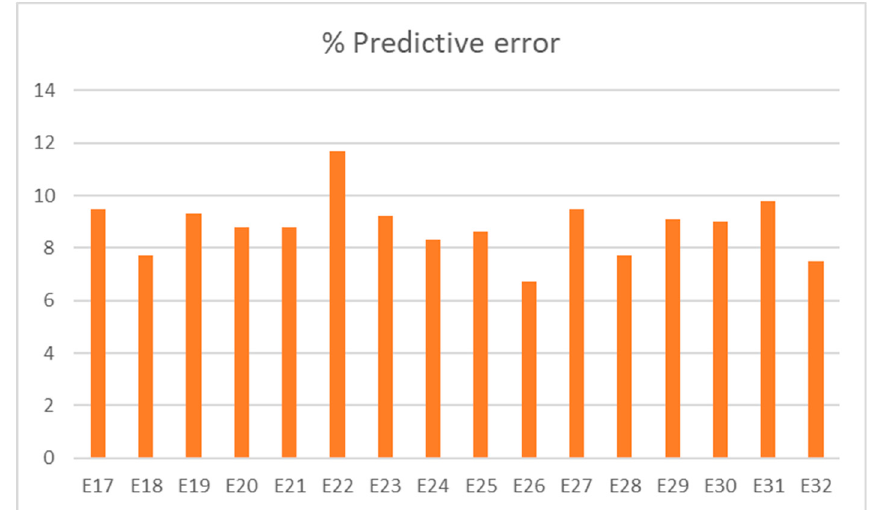
Figure 10. Predictive Error Graph for Al.